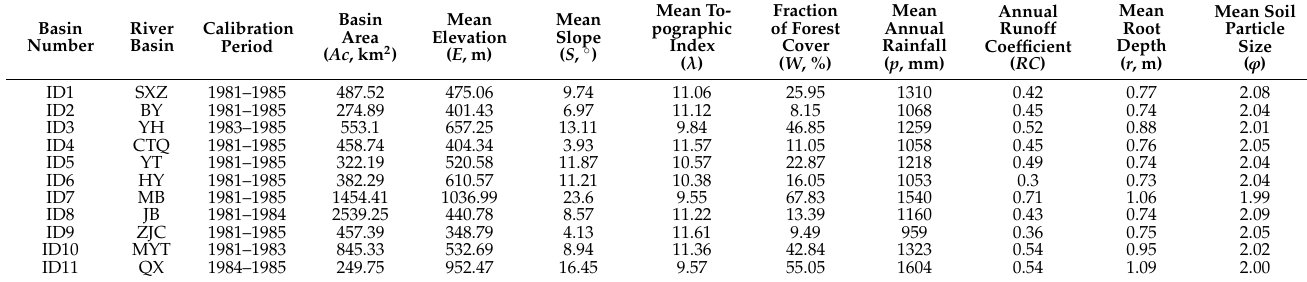
Table 2. Attribute characteristics of research